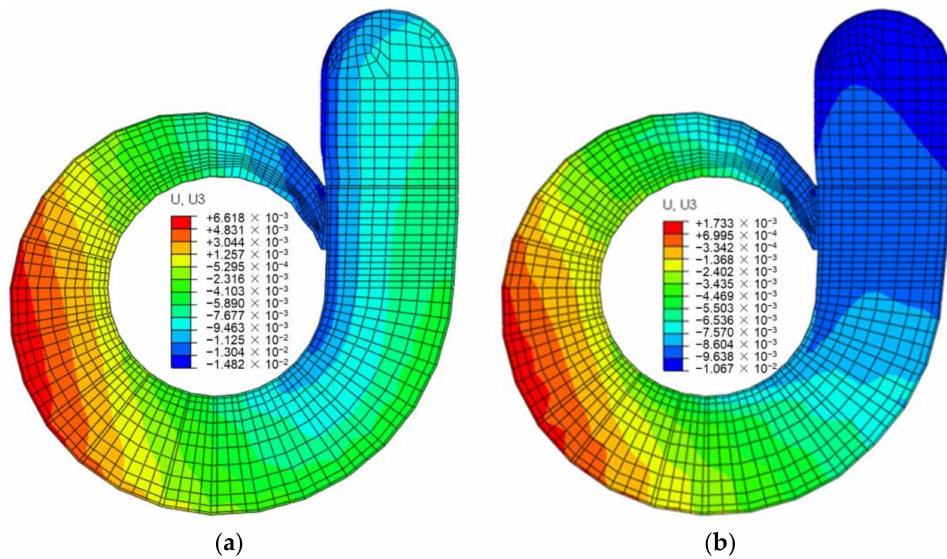
Figure 18. Displacement of the SSC in flow direction (m): ( a ) non-circle case; ( b ) circle